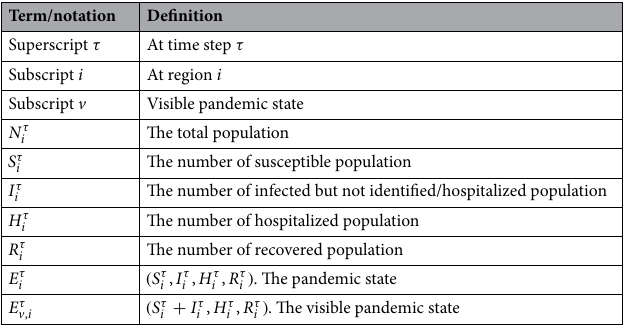
Table 2. The summary of pandemic-related notations.